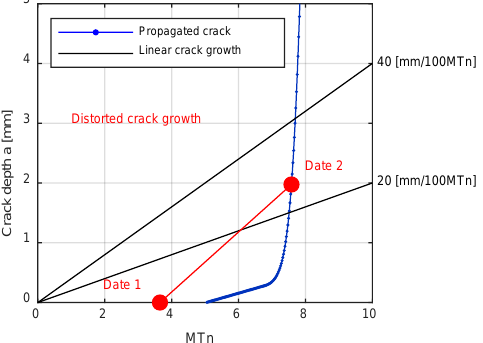
Figure 8. Crack prediction and associated crack growth rates for different moments.